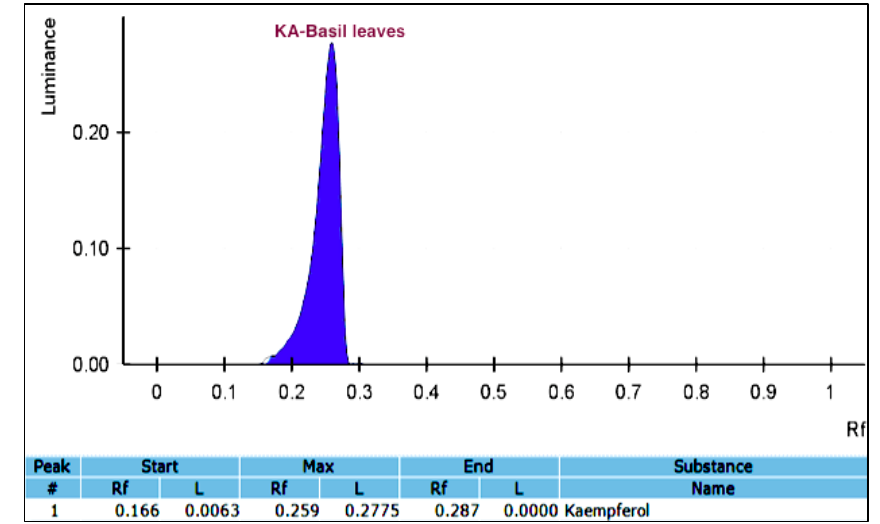
Figure 4. HPTLC chromatogram of KA in the methanol extract of ultrasonicated basil leaves ( Ocimum basilicum ) under the optimized conditions. Rf, Retention factor. #, number; L, lowest distance. Sample concentrations within the range of 50–400 ng/spot were selected to study the range of linearity (Table 3). The obtained data were close to unity and fit a linear model (R 2 = 0.99). Validation parameters such as the LOD and the LOQ were used to confirm the accuracy and precision of the proposed method with reproducible results. The validation parameters in the current study were large (LOD = 8.16 ng; LOQ = 18.142 ng), indicating that the method used here was more sensitive than the HPTLC methods used for previous KA analyses [33]. A recovery exceeding 98% was observed for the accuracy study (Table 4). For the precision test, a recovery of less than 2% was observed for the relative standard deviation (RSD) for inter-day and inter-day variations, suggesting that the proposed method had outstanding precision (Table 5). Table 3. Validation parameters for High-Performance Liquid Chromatography (HPLC). LOD: limit of detection; LOQ: limit of quantitation. Rf, Retention factor. Validation Parameter